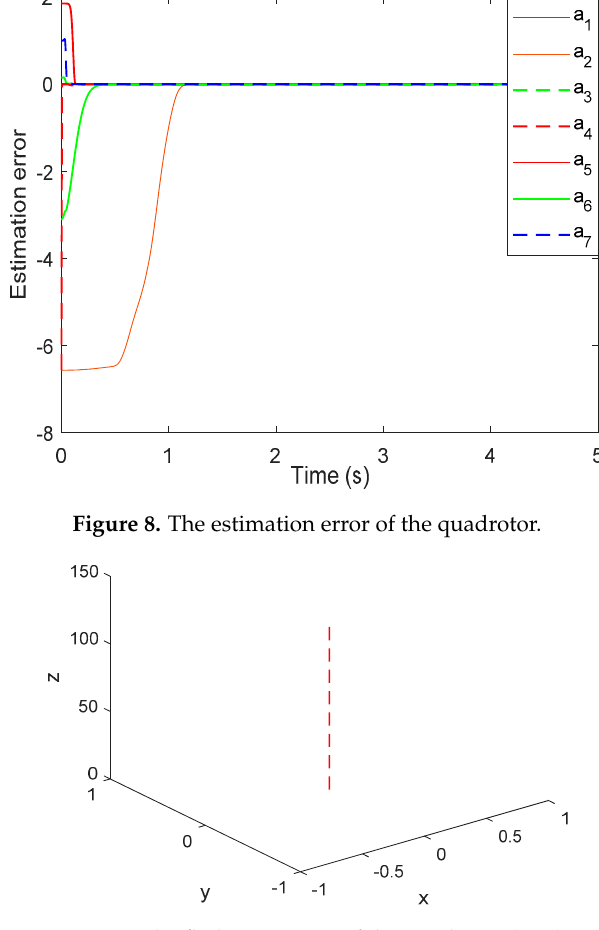
Figure 9. The flight trajectory of the quadrotor (mm).